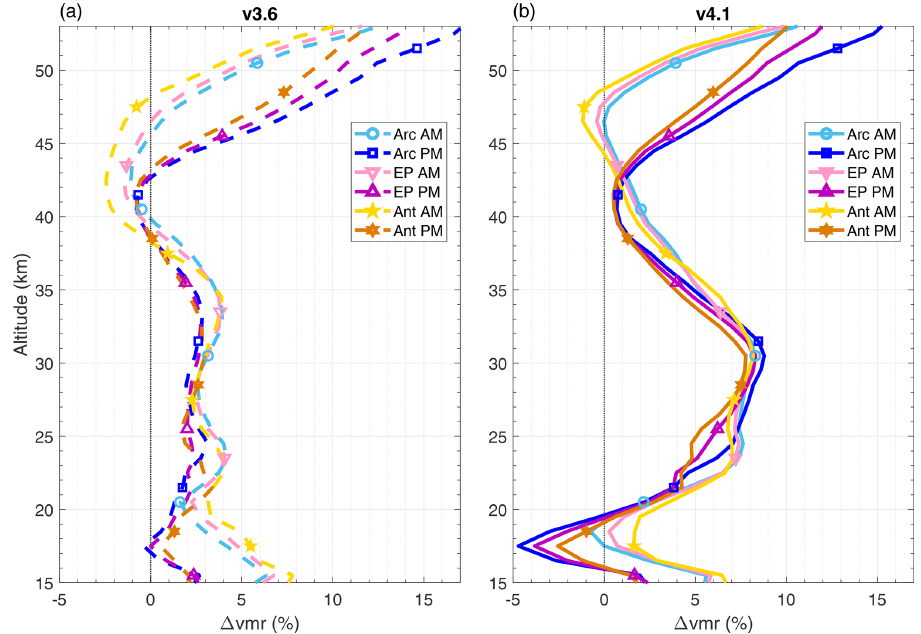
Figure 8. Weighted-average percent biases between ACE-FTS O 3 and INST for comparisons in different local time and latitudinal bins of Arctic (Arc), extra-polar (EP), and Antarctic (Ant), and with coincidence criteria of within 6h and 300km. (a) ACE-FTS v3.6 and (b)